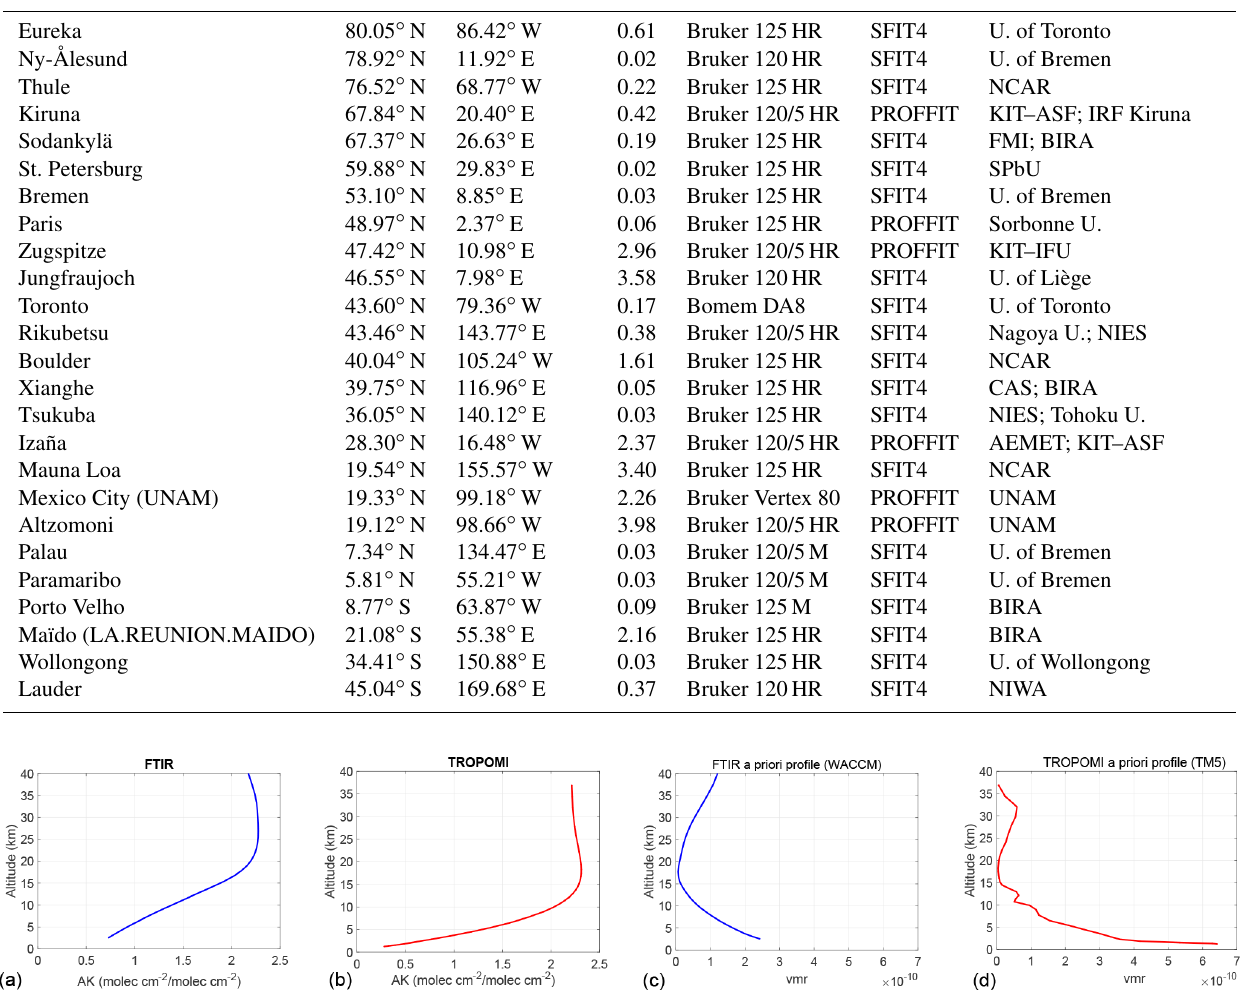
Figure 2. (a, b) Typical total column averaging kernel (AK) from FTIR (blue) and TROPOMI (red) measurements at the Maïdo station (altitude: 2.2km). (c, d) A priori profile used in the FTIR retrievals for the whole time series at Maïdo (blue), and an example of TROPOMI a priori profile at Maïdo (the 18 January